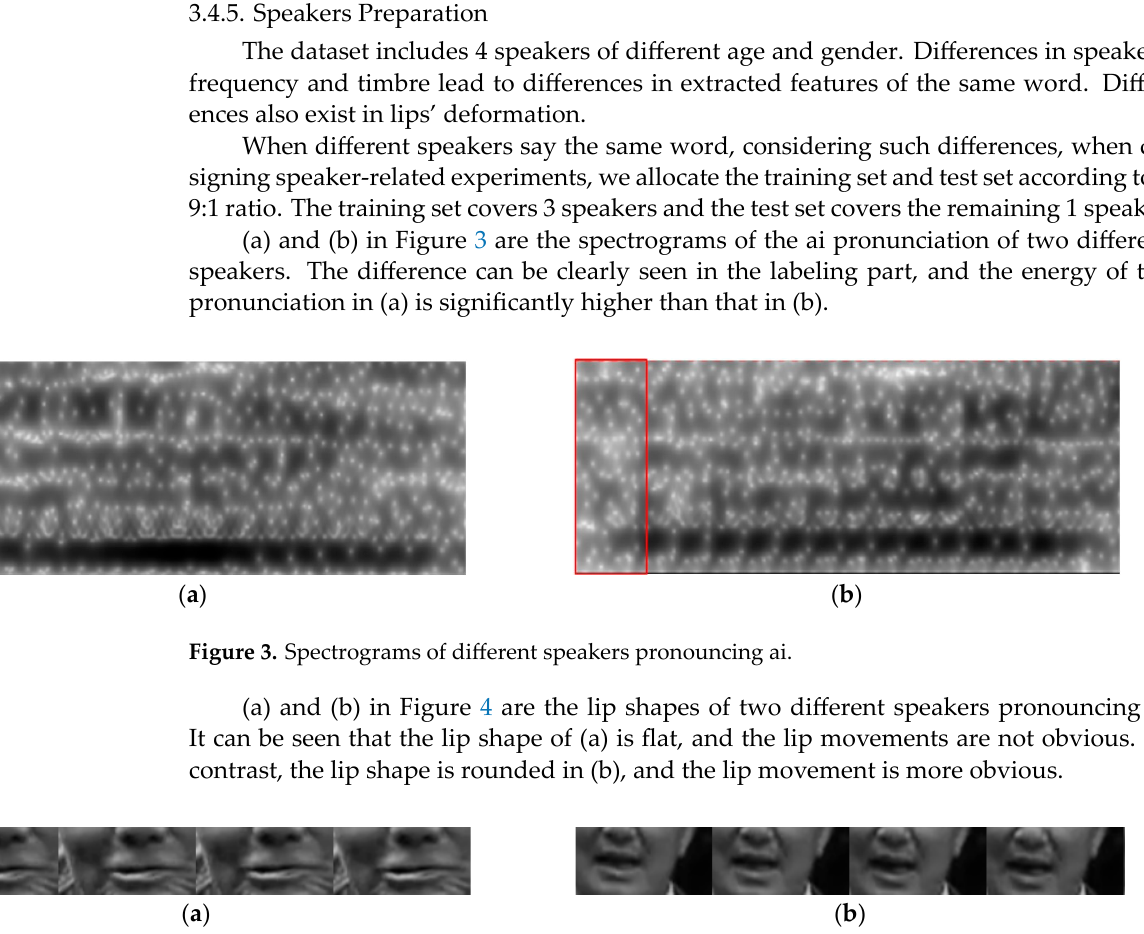
Figure 4. Lips’ shape of different speakers pronouncing ai .